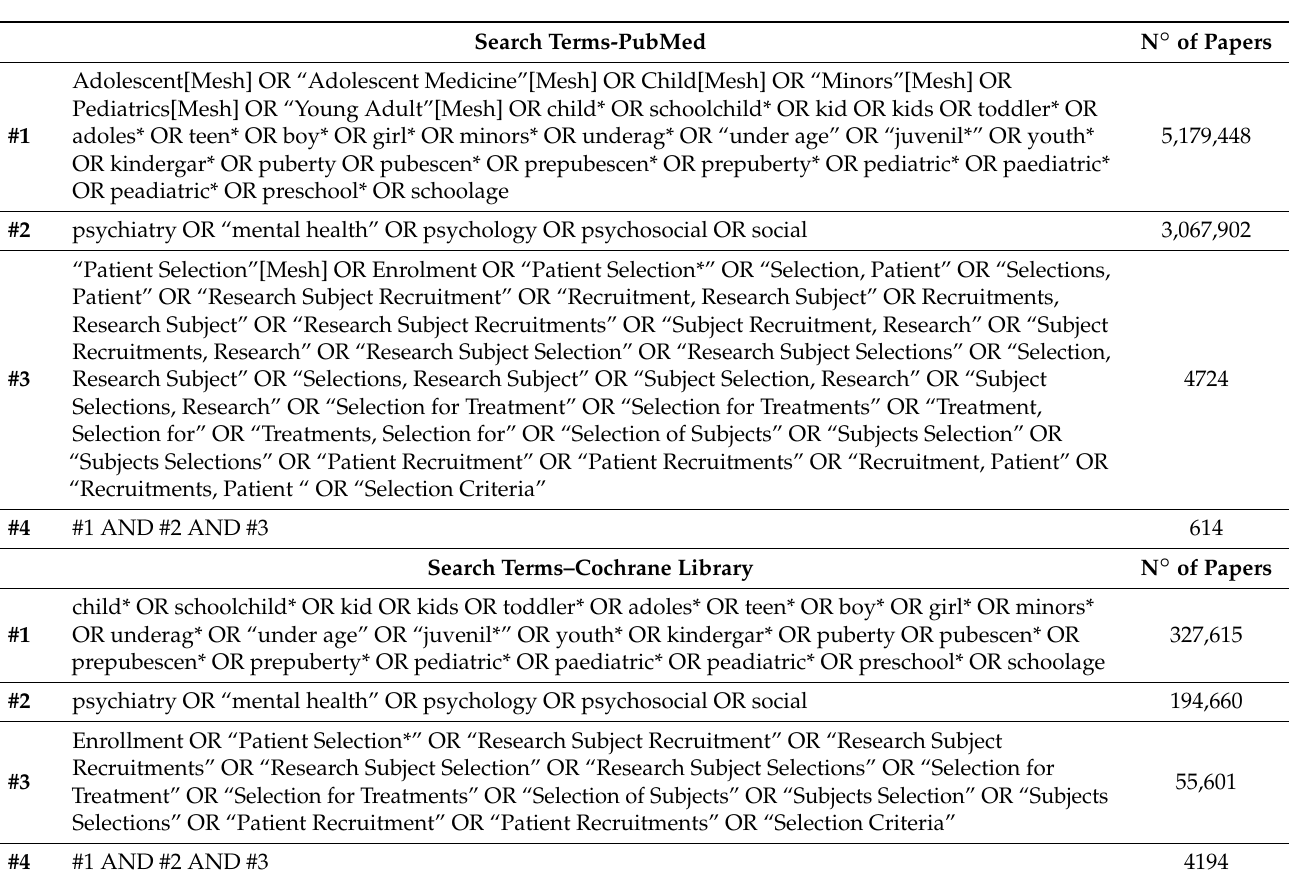
Figure 1. Flowchart of studies included in the review. Table 1. Search